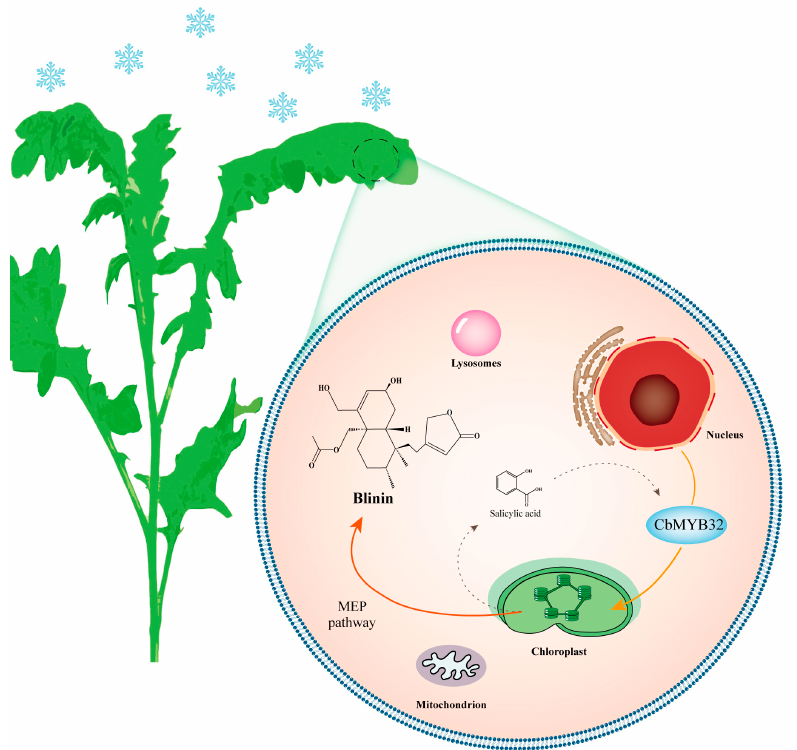
Figure 6. A model for NLS in C. blinii mediated by CbMYB32. Under NLS, CbMYB32 can enhance the terpenoid metabolism activity of C. blinii by activating blinin biosynthesis in the MEP pathway, which may connect with the SA signal pathway. The solid line represents the upstream stress signal transduction. The dashed line indicates that there may be an activation reaction.